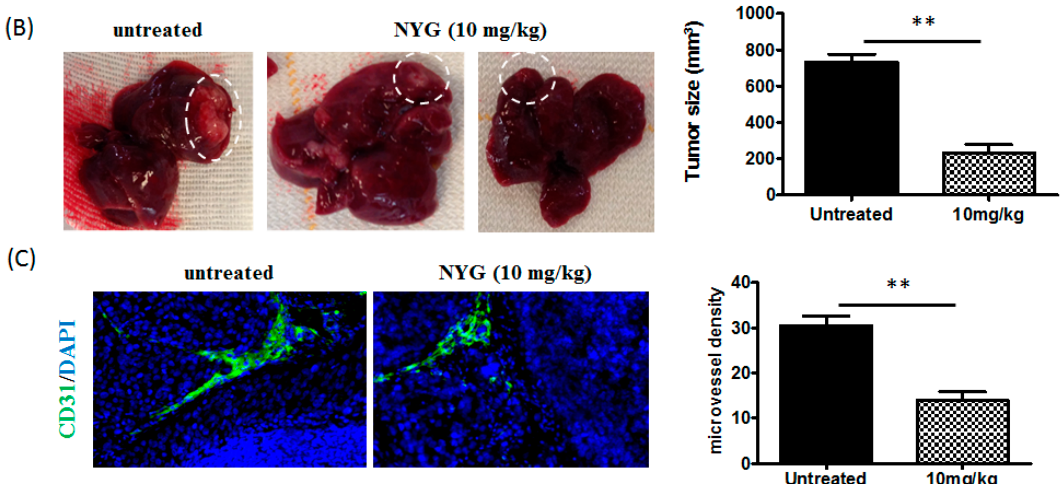
Figure 2. NYG inhibited orthotopic growth of HCC in vivo. ( A ) The orthotopic growth of HCC was monitored by imaging of luciferin signal every week after model establishment. The orthotopic HCC growth rate is slower in NYG treatment group as compared to saline-given group of mice; ( B ) The liver were excised after five weeks of NYG treatment. The representative photograph showed reduced orthotopic tumor growth in NYG-treated mice group as compared to saline-treated group. After NYG treatment, the significant reduced tumor volume is observed; The orthotopic grown tumor nodules are indicated by circle; ( C ) Histological sections of excised orthotopic HCC tumor staining with CD31 antibody in control and NYG-treated mice (10 mg/kg). The vascular density of each section was measured as the mean number of microvessels in five histological areas (100× magnification). NYG intervention significantly reduced CD31-stained microvessel density in orthotopic HCC implanted mice. ** p < 0.01.